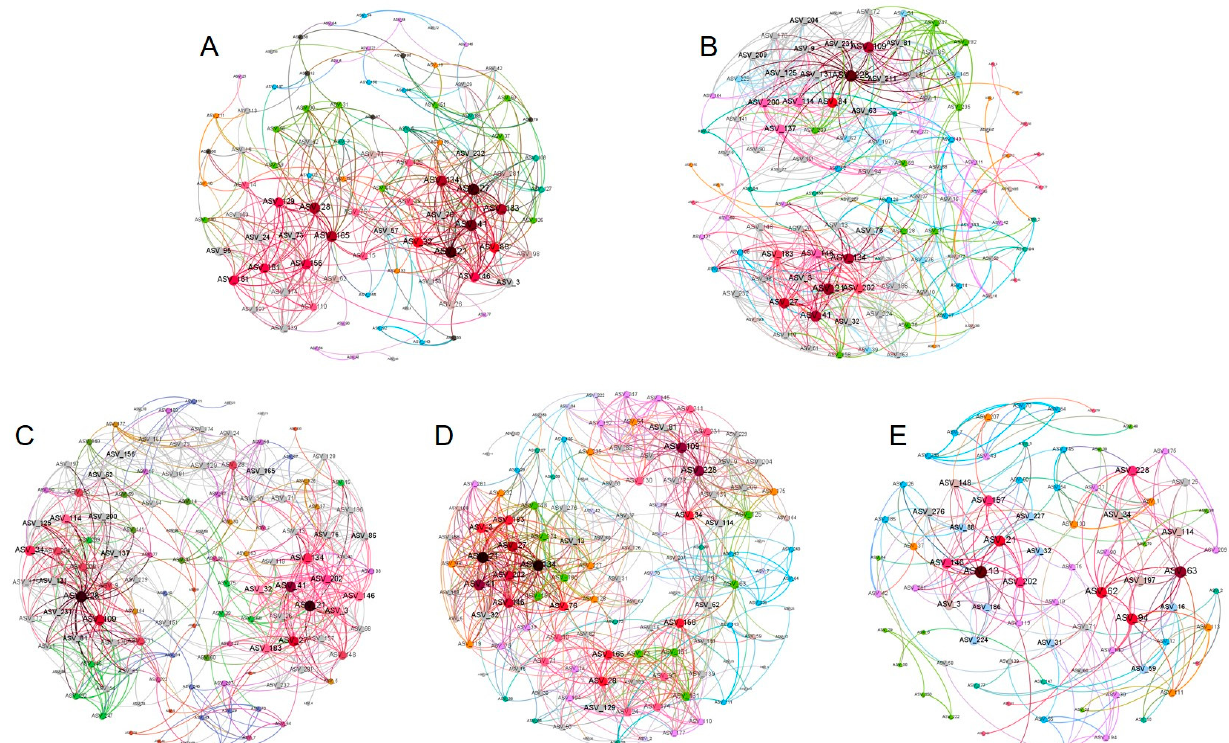
Figure 6. Co-occurrence network of the soil bacterial community for YF_1Y ( A ), YF_5Y ( B ), YF_10Y ( C ), YF_15Y ( D ), and YF_20Y ( E ) treatment. Nodes represent ASVs, edge indicats a significant positive correlation between the two ASVs, the size of the node represents the number of edges connected to the node, the thickness of the edge represents the degree of correlation, and the same color represents the same module.